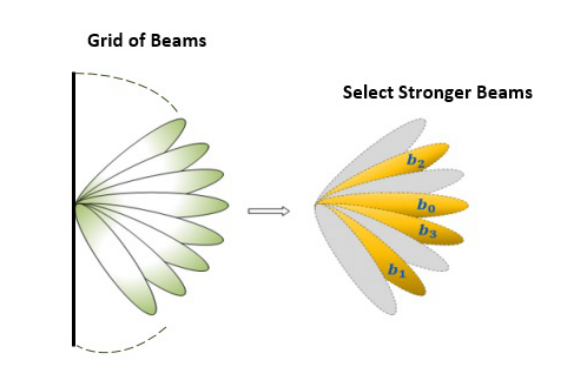
Fig. 6. Flow chart of research method